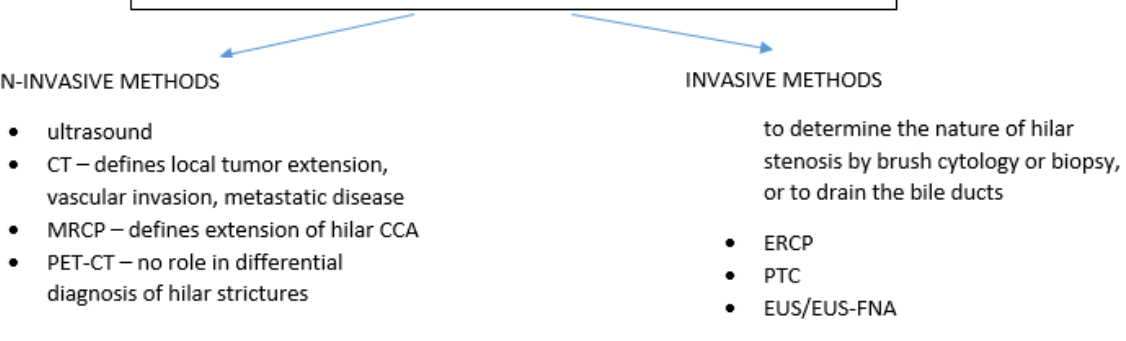
Figure 2. Diagnosis of hilar stenosis.